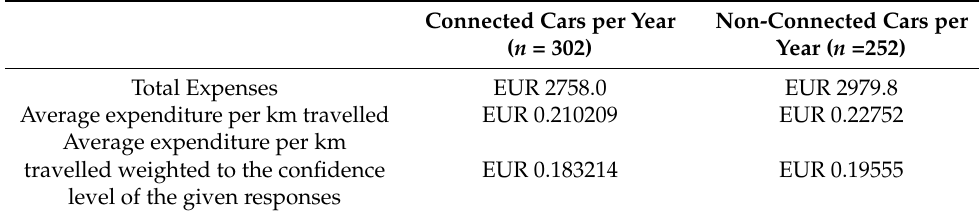
Table 8. Total expenses and average expenditures on a year basis presented first without taking into account the confidence level and then by weighting the data according to